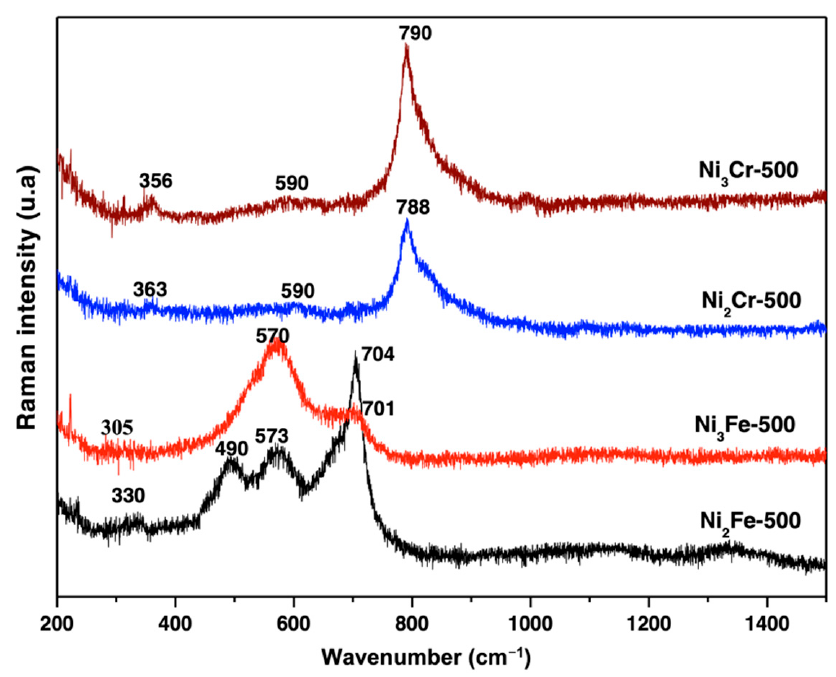
Figure 7. Raman spectra of Ni R Cr-500 and Ni R Fe-500.